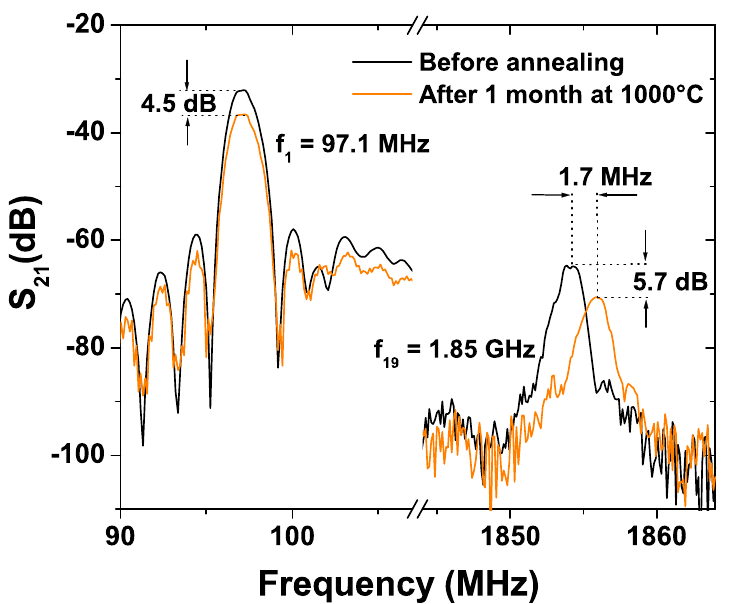
Figure 9. S 21 magnitude frequency response (1st and 19th harmonics) of SAW delay lines built from reference and annealed LGS crystals. Table 2. Main results from SAW